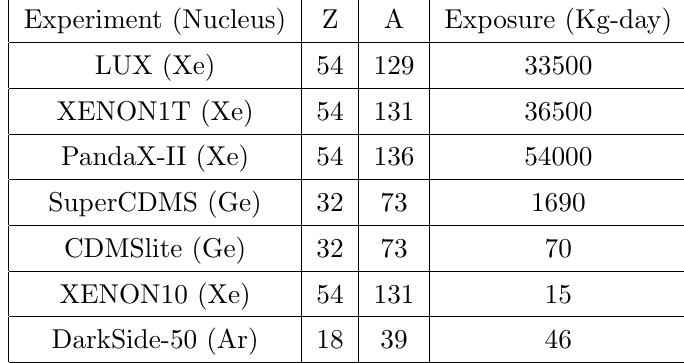
Table 3 . Detector information for the current experiments considering in this study for the com- putation of di(cid:11)erential scattering event rates in this